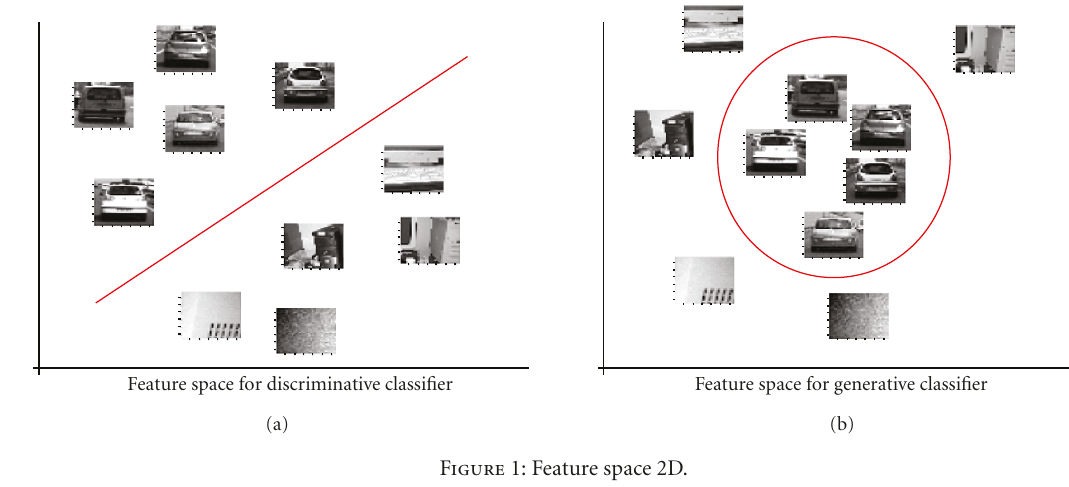
Figure 1: Feature space